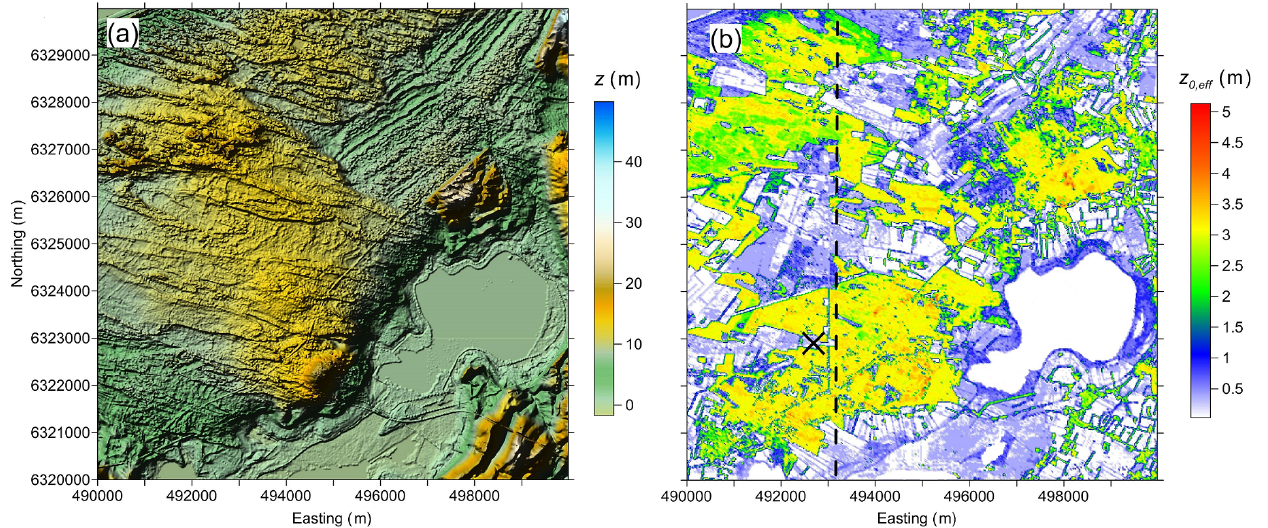
Figure 2. (a) Shaded relief plot of the elevation and (b) horizontal distribution of modelled effective roughness, z 0 , eff , at Østerild. Elevation map was produced using freely available data from Styrelsen for dataforsyning og effektiviseri , DHM-2007/Terræn (1.6m grid) (DHM – Danmarks Højdemodel, http://download.kortforsyningen.dk, last access: June 2019). The calculation resolution is 16m × 16m. Cross indicates the location of measuring tower. Dashed line indicates transect used for modelling results presented in Fig. 5.